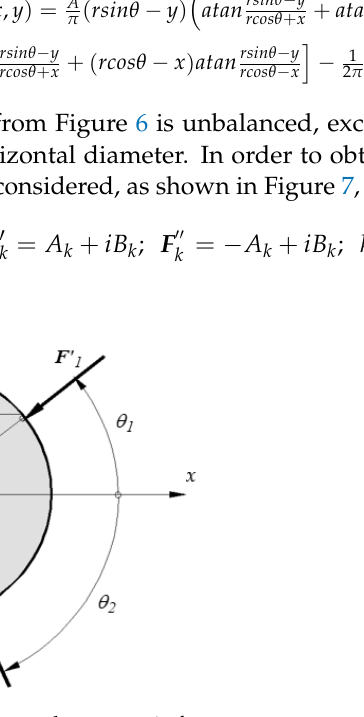
Figure 7. Loading by a balanced symmetric force system.